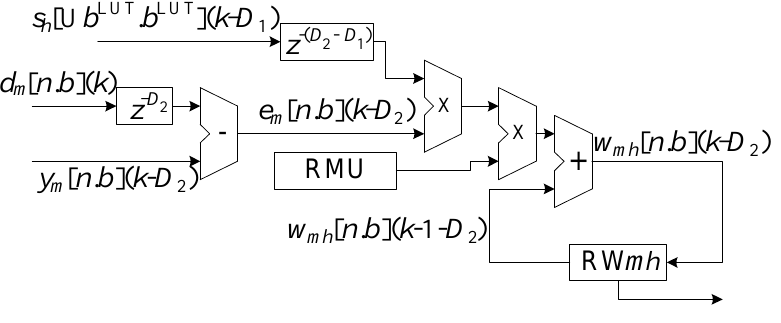
( k ) , according to Equation mh